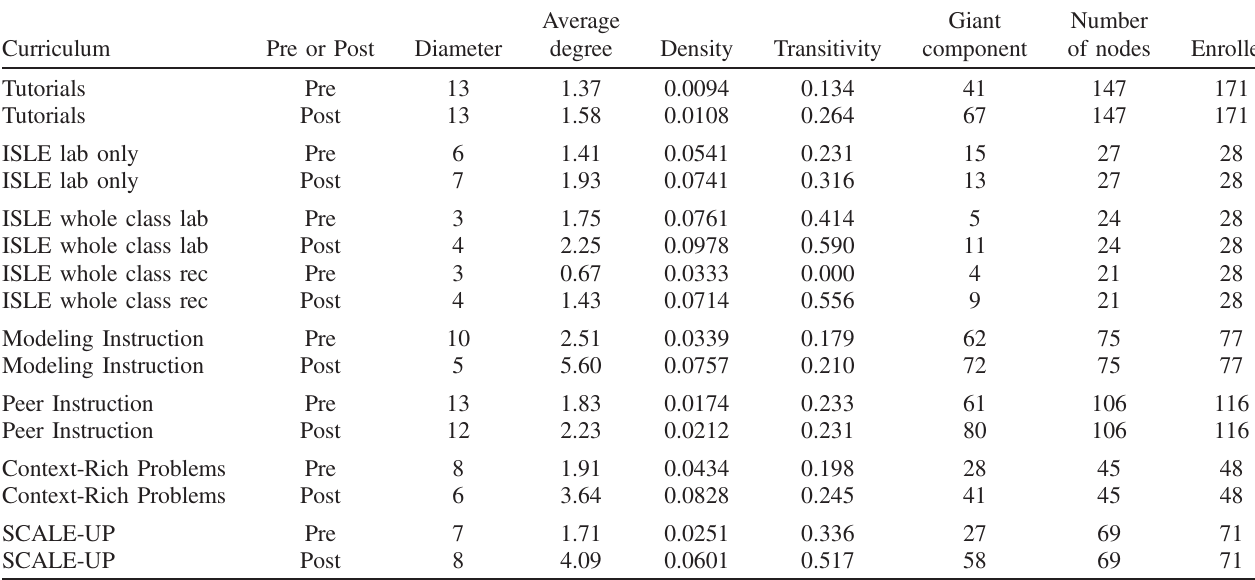
TABLE VI. Network metrics for six active learning curricula in physics: diameter, average degree, edge density, transitivity, size of giant component, number of nodes, and students enrolled in the section. The section with the highest response rate within each pedagogy is